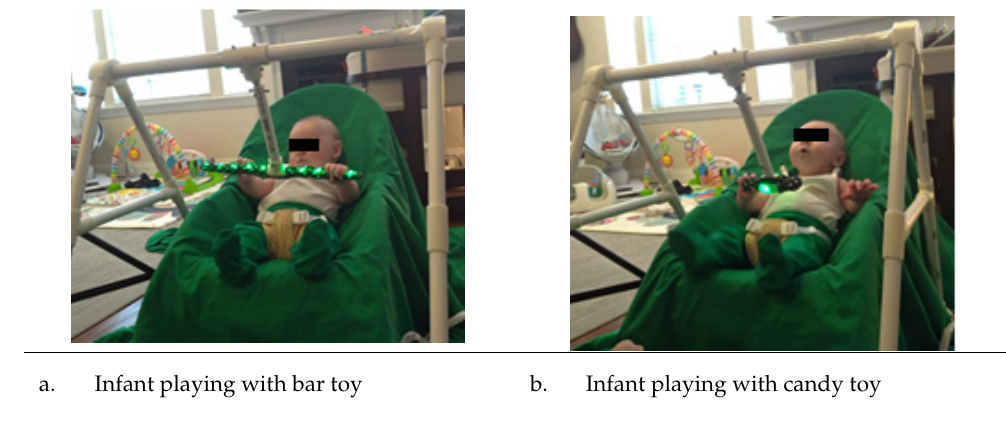
Table 1. Infant interaction with HUGS ‐ 1.